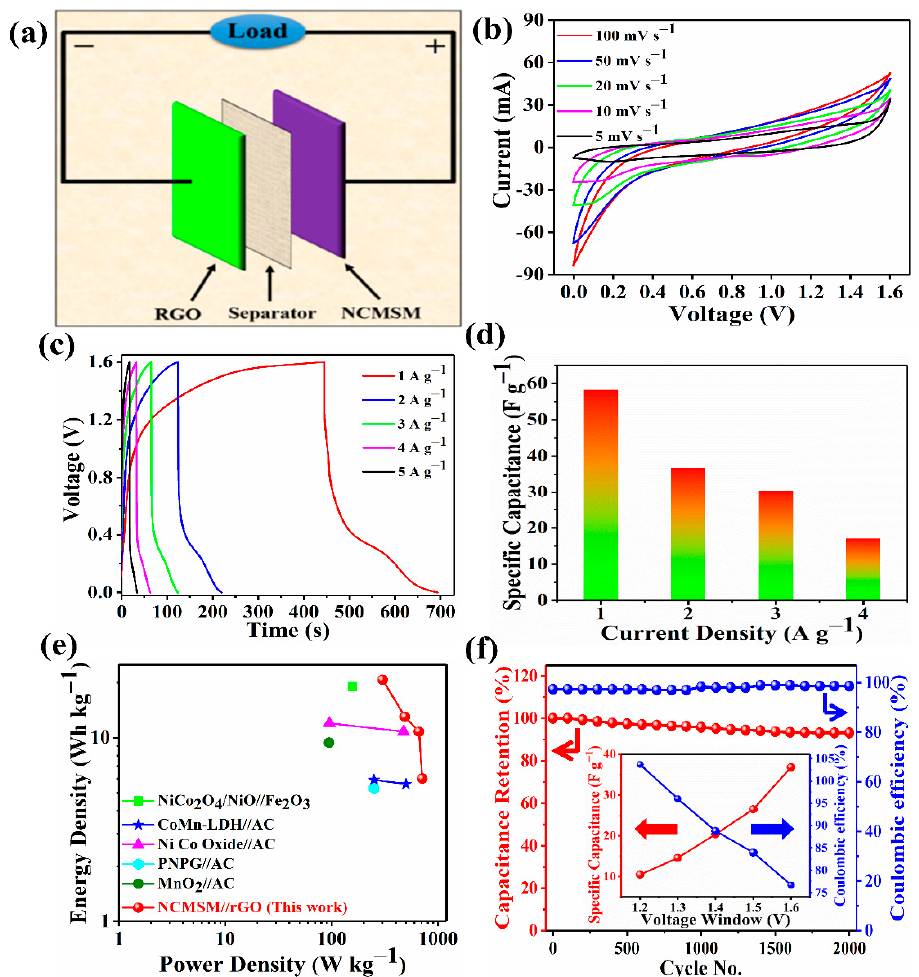
Figure 12. Electrochemical performance of the as-prepared aqueous asymmetric SC (AASC, NCMSM//rGO): ( a ) schematic diagram of the device, ( b ) CV curves at various scan rates within a fixed potential window of 1.6 V, ( c ) galvanostatic charge-discharge curves at several current densities, ( d ) histogram of the C s as a function of the current density, ( e ) Ragone plot, and ( f ) cycling stability curve (measured at the current density of 5 A g − 1 ); the inset shows the C s of the device at different potential windows from 1.2 to 1.6 V. Table 1. Comparison of electrochemical performances of NCMSM//rGO SASC and AASC devices.